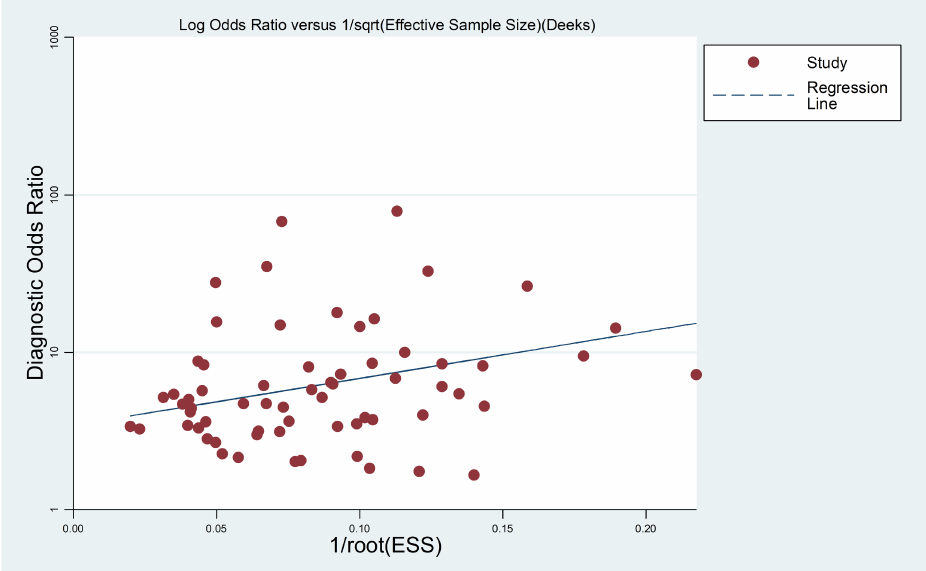
Figure 5 - Linear regression test of funnel plot asymmetry. The statistically non-significant P value of the slop coefficient indicates symmetry of the data and a low likelihood of publication